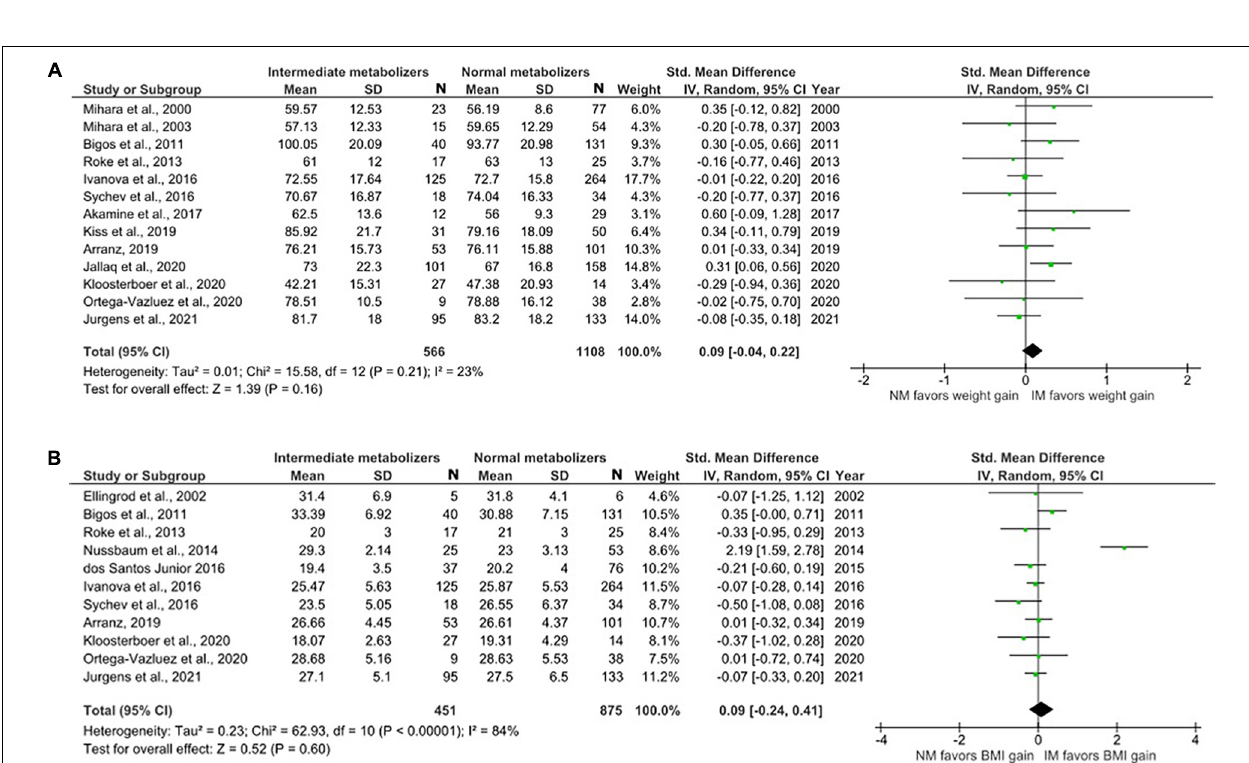
FIGURE 2 | Forest plots comparing (A) standardized mean weight differences (B) standardized mean BMI differences between Poor metabolizers and Normal metabolizers. Random effects model and inverse variance method were use. CI, confidence interval; df, degree of freedom; N, number of participants; SD, standard deviation; SMD, standardized mean difference.